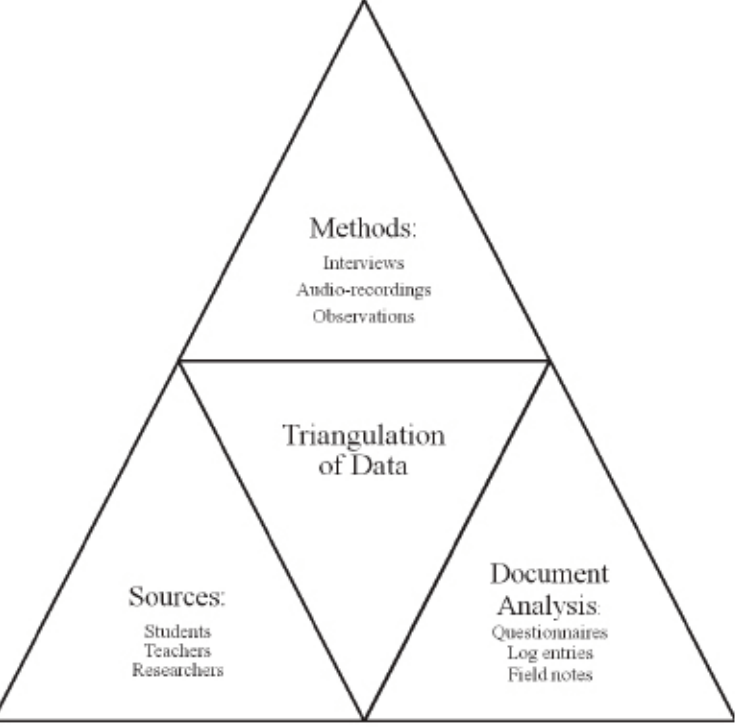
Figure 1. Data triangulation including methods, sources, and document